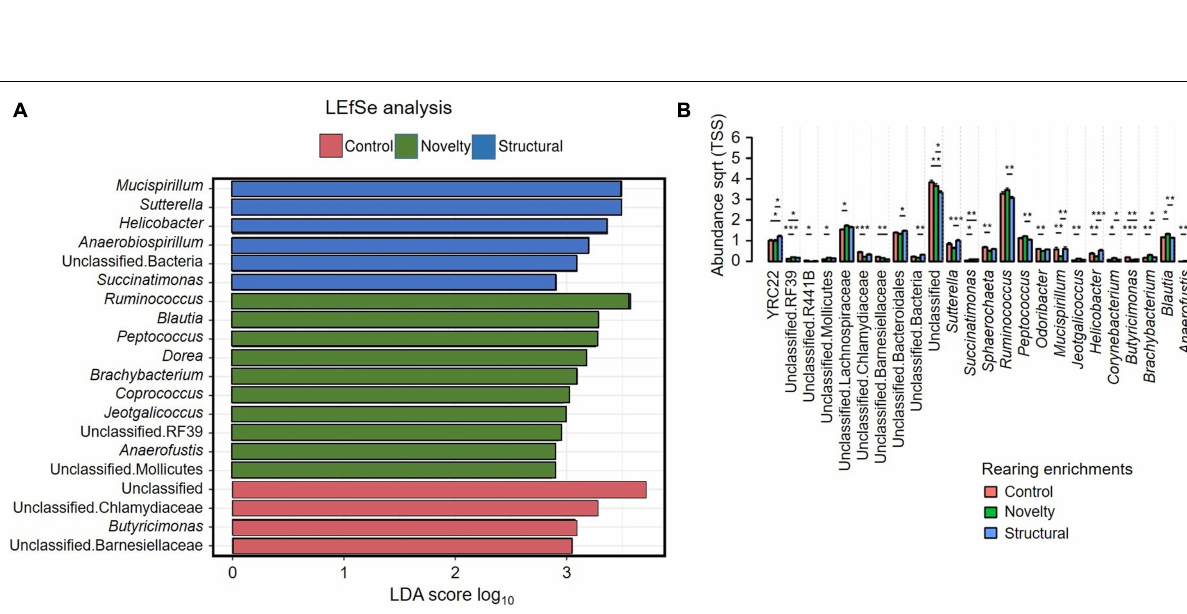
Frontiers in Microbiology |